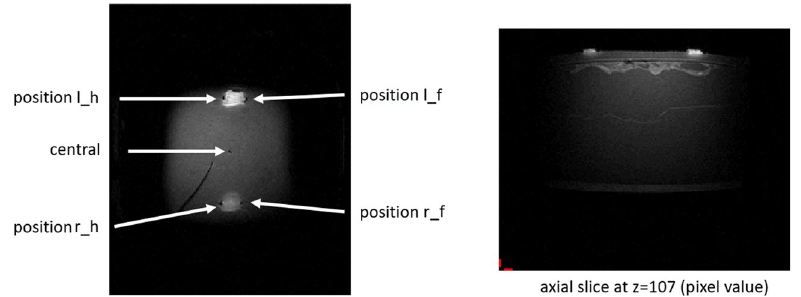
Figure 12. MRI image of head phantom with polymer electrodes. In the top view on the left, the temperature sensors are marked with arrows. position l_h means back left, position r_f means front right. The central temperature sensor can also be seen as a small black dot. An axial slice can be seen on the right. The interruption of the structure by the lid and slight unevenness, presumably due to air pockets in the agarose under the lid can be seen. The polymer electrodes have no significant effect on the image quality in the MRI.